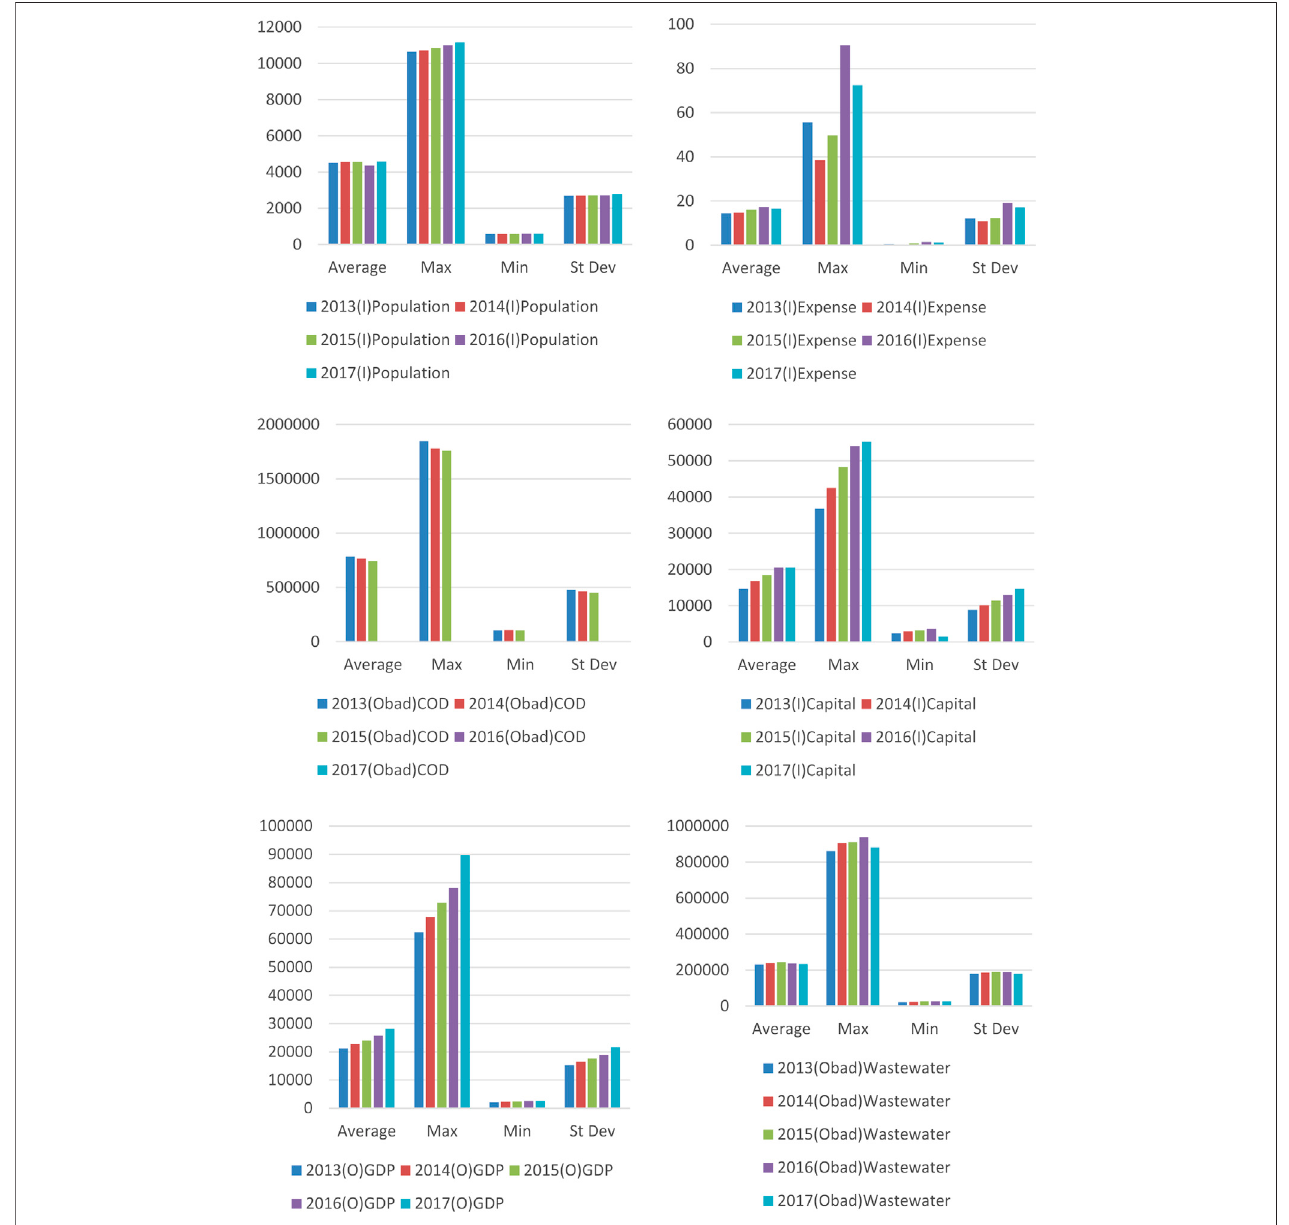
FIGURE 2 | Statistical analysis of input-output indicators in 2013 –